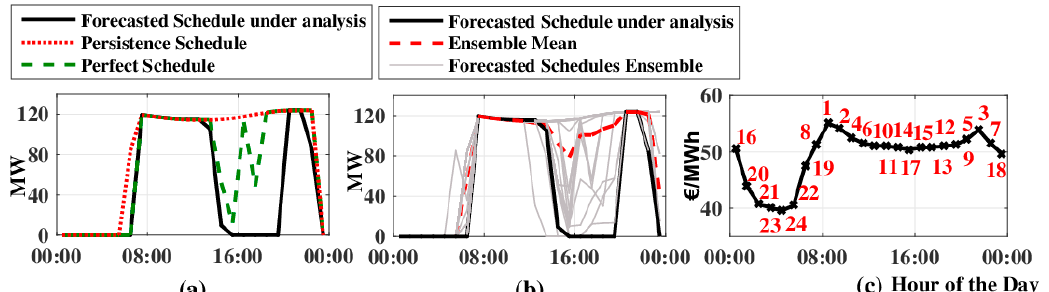
Figure 5. Learning parameters explanatory graph: perfect and persistence schedules ( a ); probabilistic ensemble of possible schedules, ensemble mean and a schedule under analysis ( b ); expected price and, in red, hour priority ( c ).